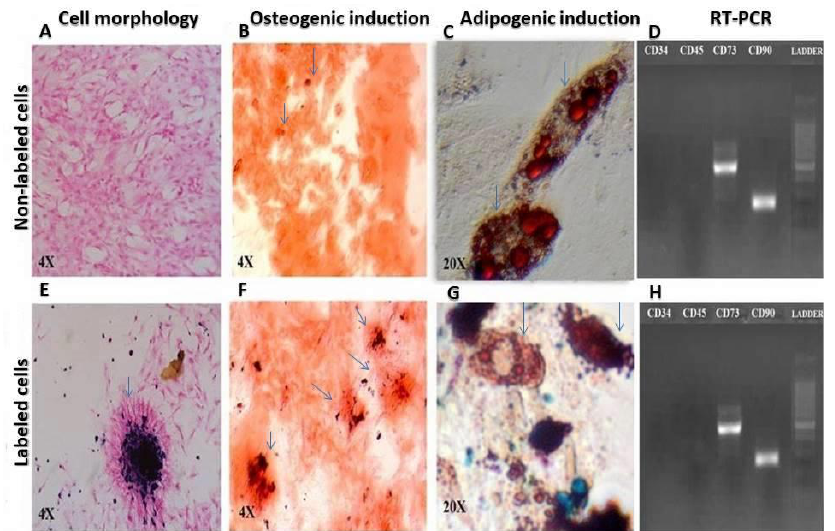
Figure 1. Comparison of cell morphology: ( A ) Non-labeled and ( E ) Lipofectamine-transfected iron ox- ide labeled cells, pointed by arrow, 4 × , osteogenic induction; ( B ) Non-labeled and ( F ) Lipofectamine- transfected iron oxide nanoparticles labeled cells, pointed by arrow, 4 × , adipogenic differentiation; ( C ) Non-labeled and ( G ) Lipofectamine-transfected iron oxide labeled cells, pointed by arrow, 20 × and RT-PCR for expression of mesenchymal and hematopoietic markers; ( D ) Non-labeled and ( H ) Lipofectamine-transfected iron oxide labeled cells).